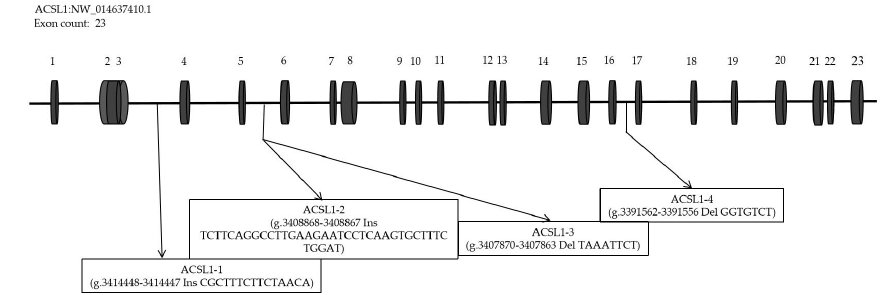
Figure 1. Schematic expression of the ACSL1 gene and location of identified mutation sites. Table 1. Primer information of Dezhou donkey ACSL1 and GAPDH genes for qPCR and ACSL1 polymorphic sites. Loci Primer sequences (5 (cid:48) –3 (cid:48) ) Tm ( ◦ ) Product length GenBank